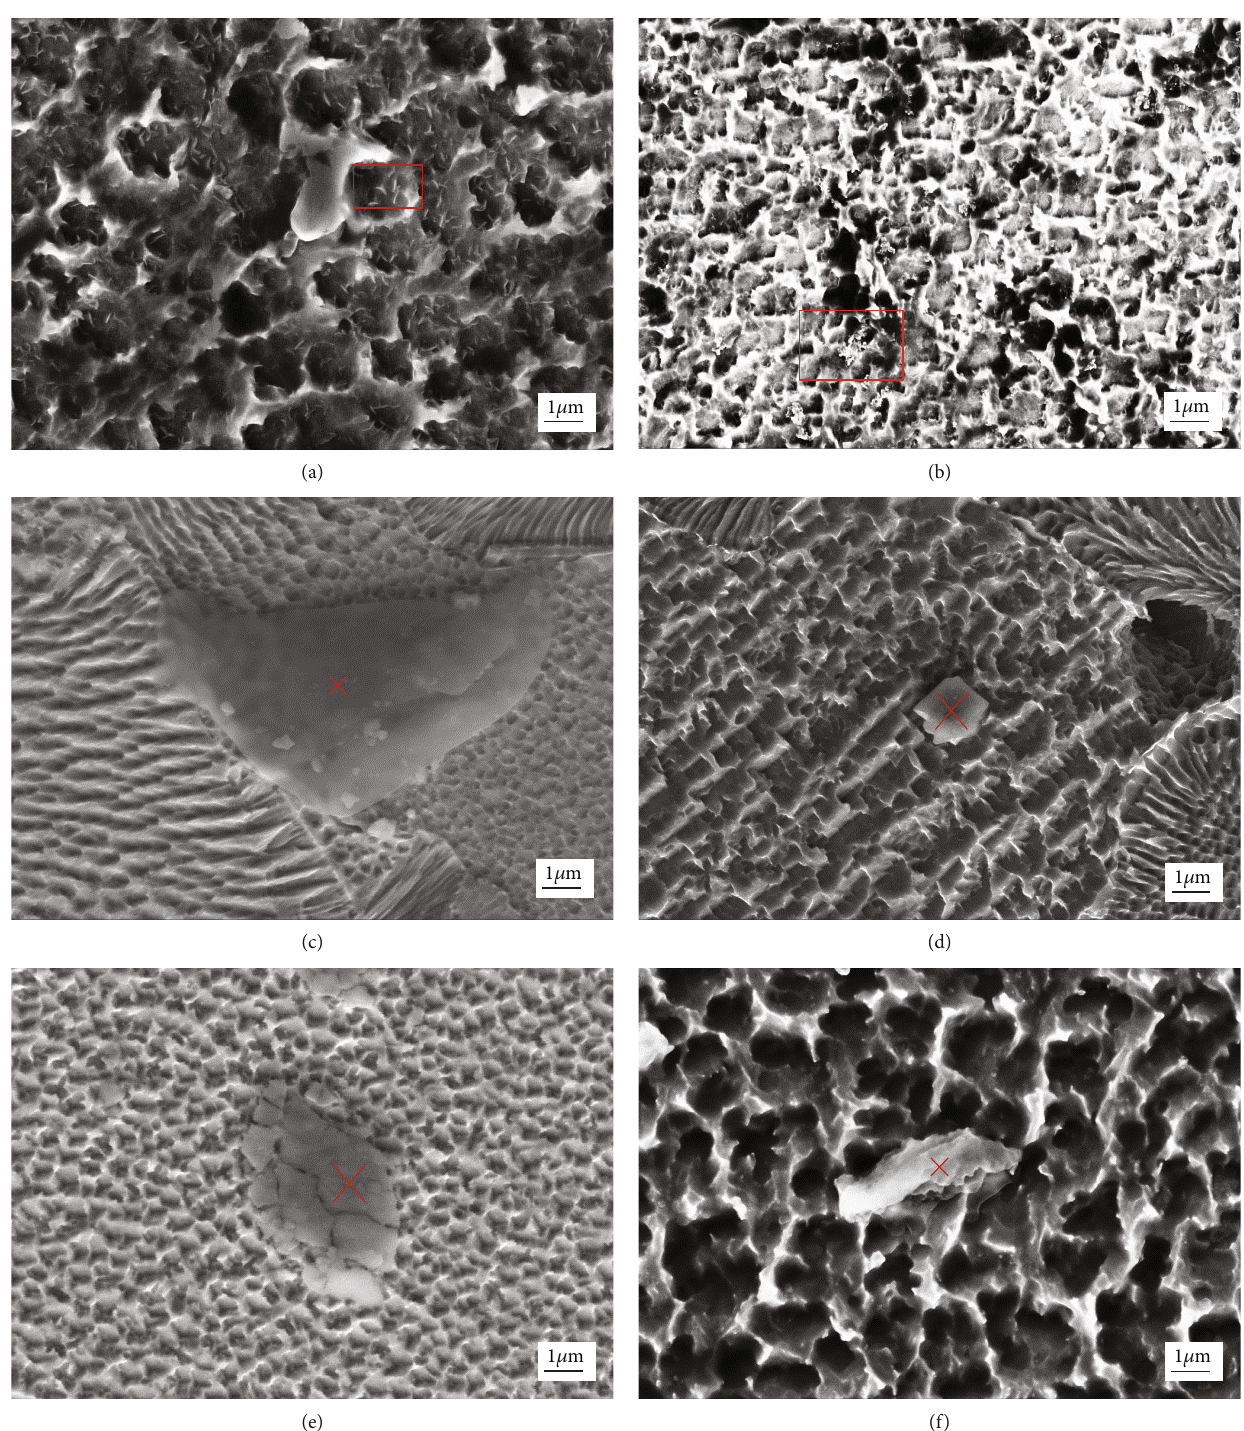
Figure 7: Microstructure of the GH4720Li alloy under di ff erent test conditions: (a) 10s -1 , 20 ° C; (b) 10s -1 , 800 ° C; (c) 1000s -1 , 20 ° C; (d) 1000s - 1 , 800 ° C; (e) 5000s -1 , 20 ° C; (f) 5000s -1 , 800 °